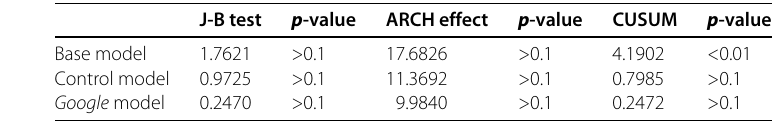
Table 5 Additional tests